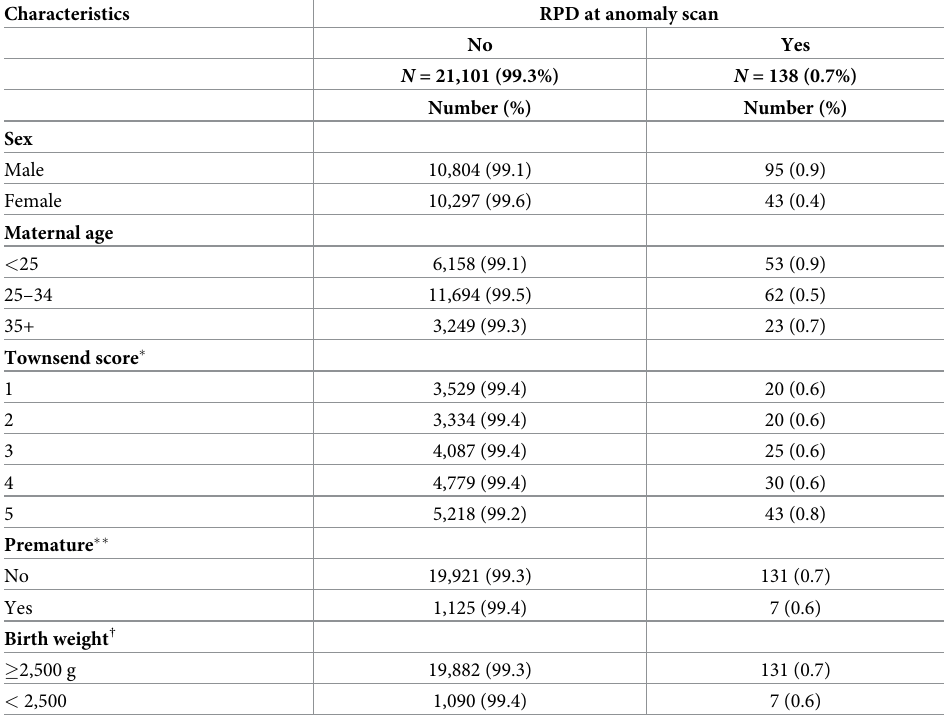
Table 1. Characteristics of the cohort, by RPD status at anomaly